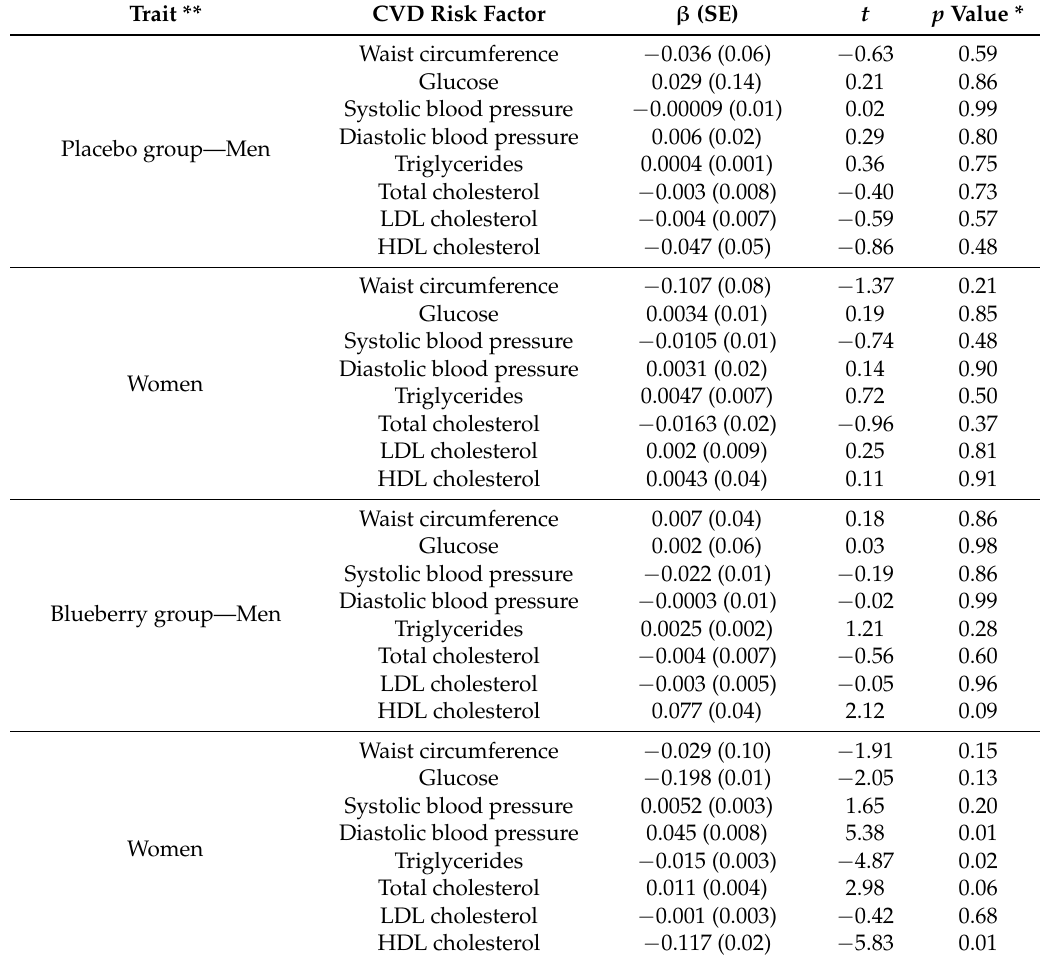
Table 4. Multiple regression analysis of changes in SUA concentrations with cardiovascular disease risk factors in the treatment